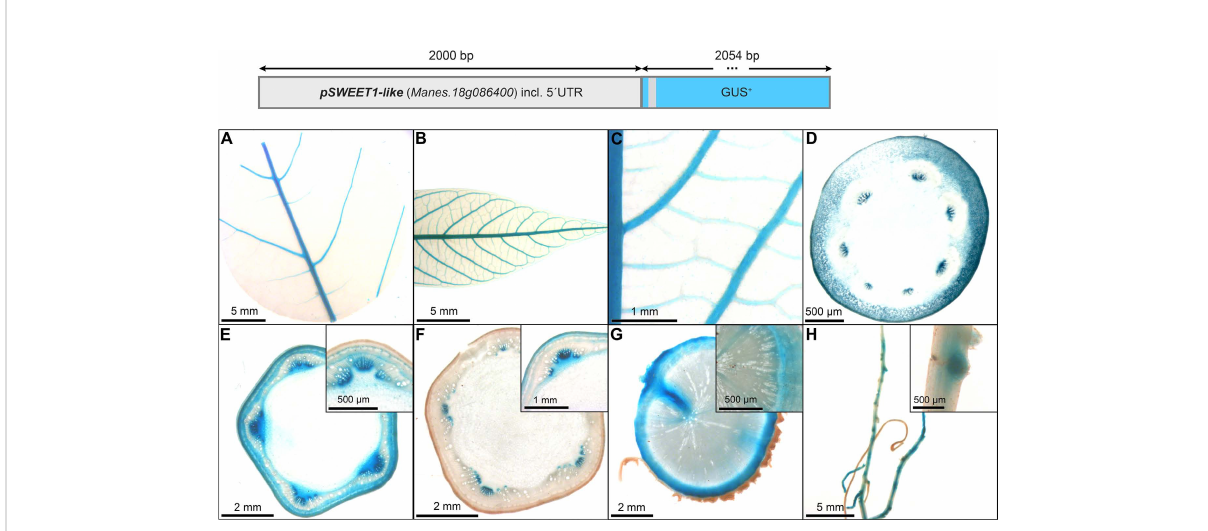
FIGURE 7 Representative GUS staining pattern of at least four pMeSWEET1-like promoter-reporter lines. (A) Source leaf, (B) Sink leaf, (C) Emerging leaves, (D) Petiole cross-section, (E) Upper stem cross-section (Inlay = Close-up), (F) Lower stem cross-section (Inlay = Close-up), (G) Storage root